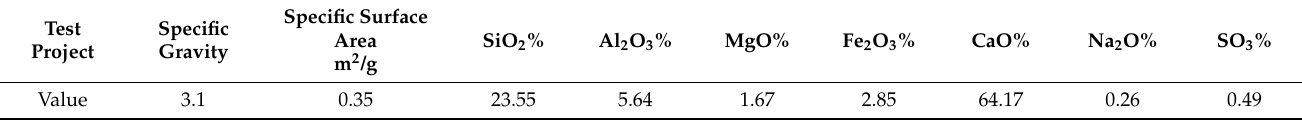
Table 2. The properties of Portland cement.